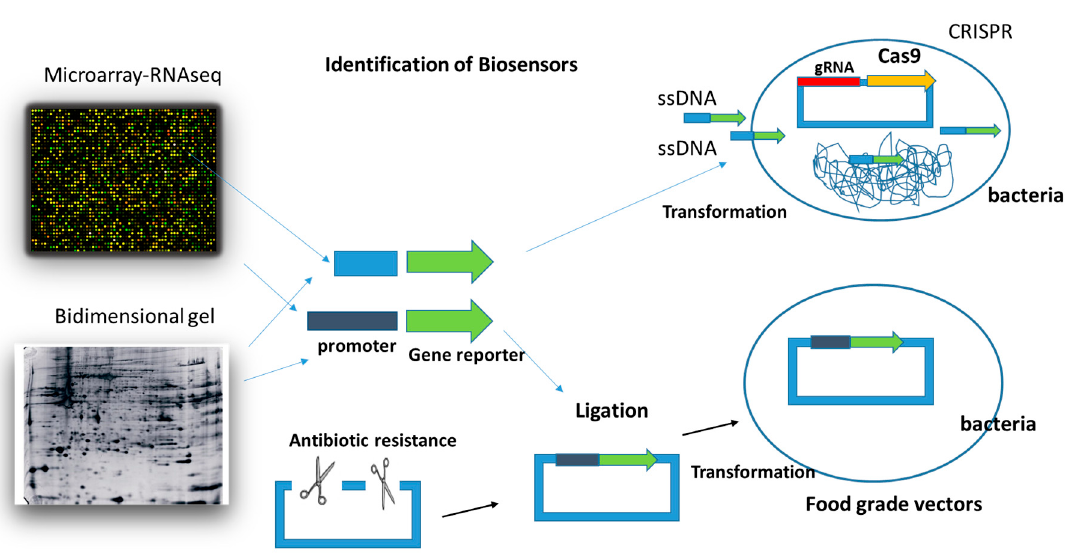
Figure 3. Transcriptomic techniques (Microarrays or RNAseq) and proteomic techniques are the main approaches to identify promoter sequences that in the presence of specific effector molecules are involved in the increase or decrease of the gene expression. The use of food-grade vectors and the CRISPR methodology for the genetic manipulation of LAB and bifidobacteria is suggested in the present work in order to use them as biosensor vehicles in foods and living beings.